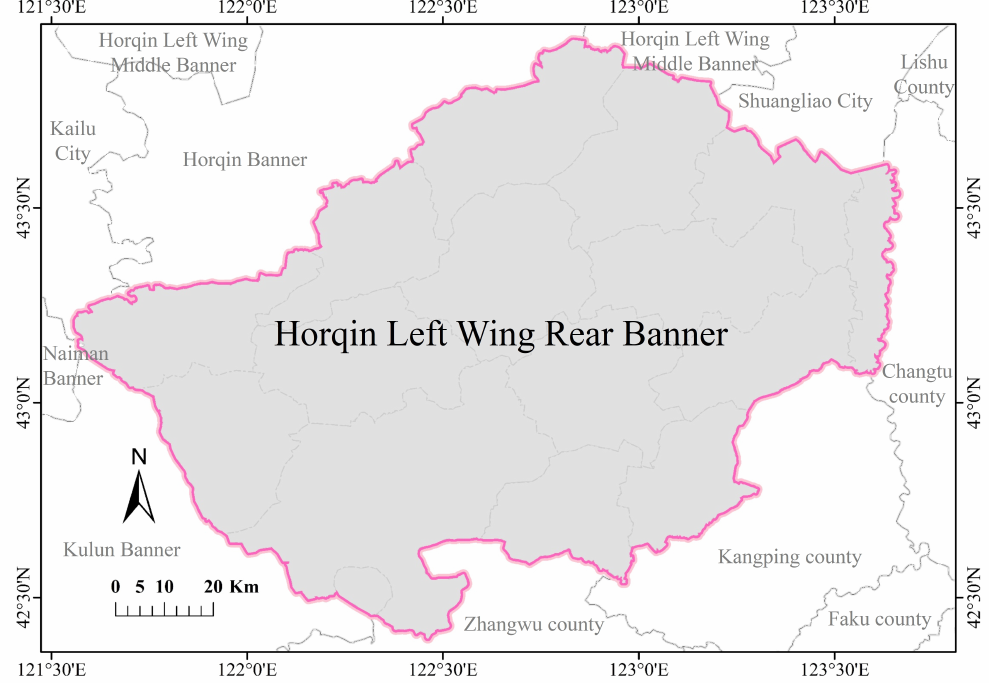
Figure 1. The location of Horqin Left Wing Rear